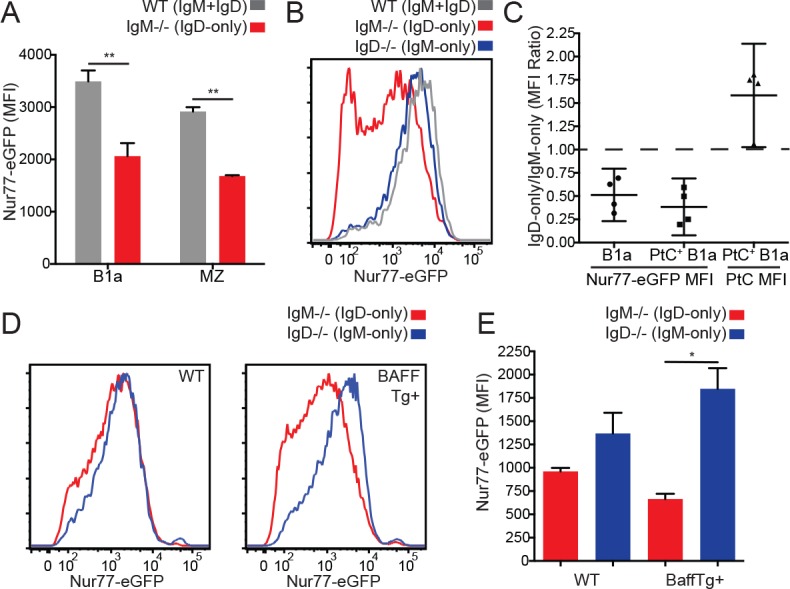
Reduced in vivo antigen sensing by IgD in innate-like B cells.(A) Nur77-eGFP in peritoneal B1a (CD19+CD5+CD23-) and splenic MZ (B220+CD21hiCD23lo) B cells from WT and IgM−/− mice. (B) Nur77-eGFP in PtC-binding peritoneal B1a cells from WT, IgM−/−, and IgD−/− mice. (C) Nur77-eGFP and PtC MFIs were calculated for total B1a and PtC-binding B1a cells. The ratio of the IgM−/− (IgD-only) MFI to the IgD−/− (IgM-only) MFI is displayed with a 95% confidence interval. (D) Representative histograms of Nur77-eGFP in IgM−/− and IgD−/− splenic MZ B cells from mice without (left) and with (right) a BAFF overexpression transgene. (E) Quantification of Nur77-eGFP in MZ B cells from (D). For (A) and (E), n = 3 mice of each genotype were analyzed. For (B), histograms are representative of n = 4 mice of each genotype. For (C), ratios are pooled for n = 4 mice of each genotype from three independent experiments. For (D), histograms are representative of n = 3 mice of each genotype. Welch’s t test (A and E) was used to calculate p values, and mean +SEM is displayed (except in C). *p<0.05.10.7554/eLife.35074.017Figure 3—source data 1.Numerical data corresponding to Nur77-eGFP and BCR expression in innate-like B cells in Figures 3A, C, E,
Figure 3—figure supplement 1A-C.Numerical data corresponding to Nur77-eGFP expression and PtC binding in B1a cells in Figure 3A and C. Numerical data corresponding to Nur77-eGFP and surface receptor levels in BaffTg+ MZ B cells in Figure 3E and Figure 3—figure supplement 1A. Numerical data corresponding to Nur77-eGFP expression in innate-like B cells in Figure 3—figure supplement 1B. Numerical data corresponding to Nur77-eGFP expression in MZ B cells in Figure 3—figure supplement 1C.10.7554/eLife.35074.018Figure 3—source data 2.Numerical data corresponding to Nur77-eGFP expression and PtC binding in B1a cells in Figure 3C.